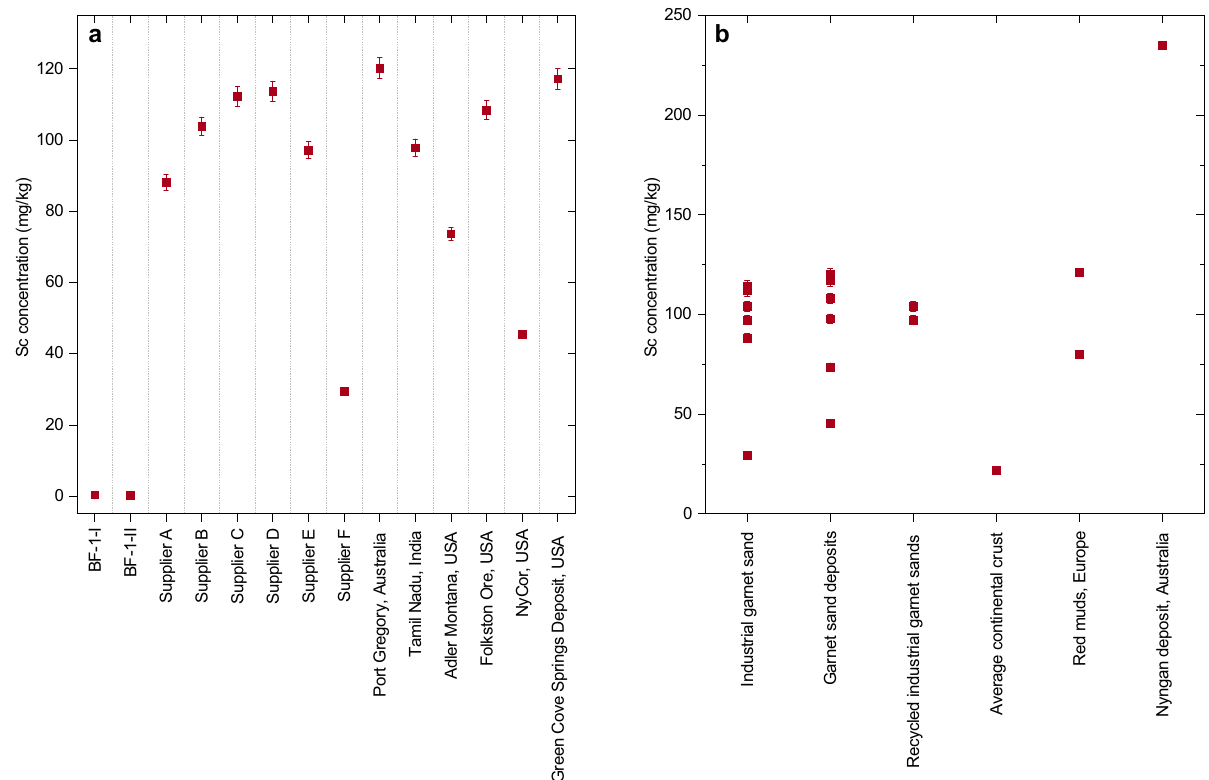
Figure 2. Scandium concentrations (mg/kg) of garnet from different mines, commercially available industrial garnet sands and hydrothermal garnet sands from the Beaumont Formation, South Africa ( a ). Scandium concentration in garnet sand from this study compared to average Sc concentrations in the continental crust 34 , the Nyngan Sc deposit, Australia 18 , and in red mud from Greece 25 and Hungary 46 ( b ). The error bars are based on 2 times the RSD of the repeated measurement of sample Supplier C b on two different